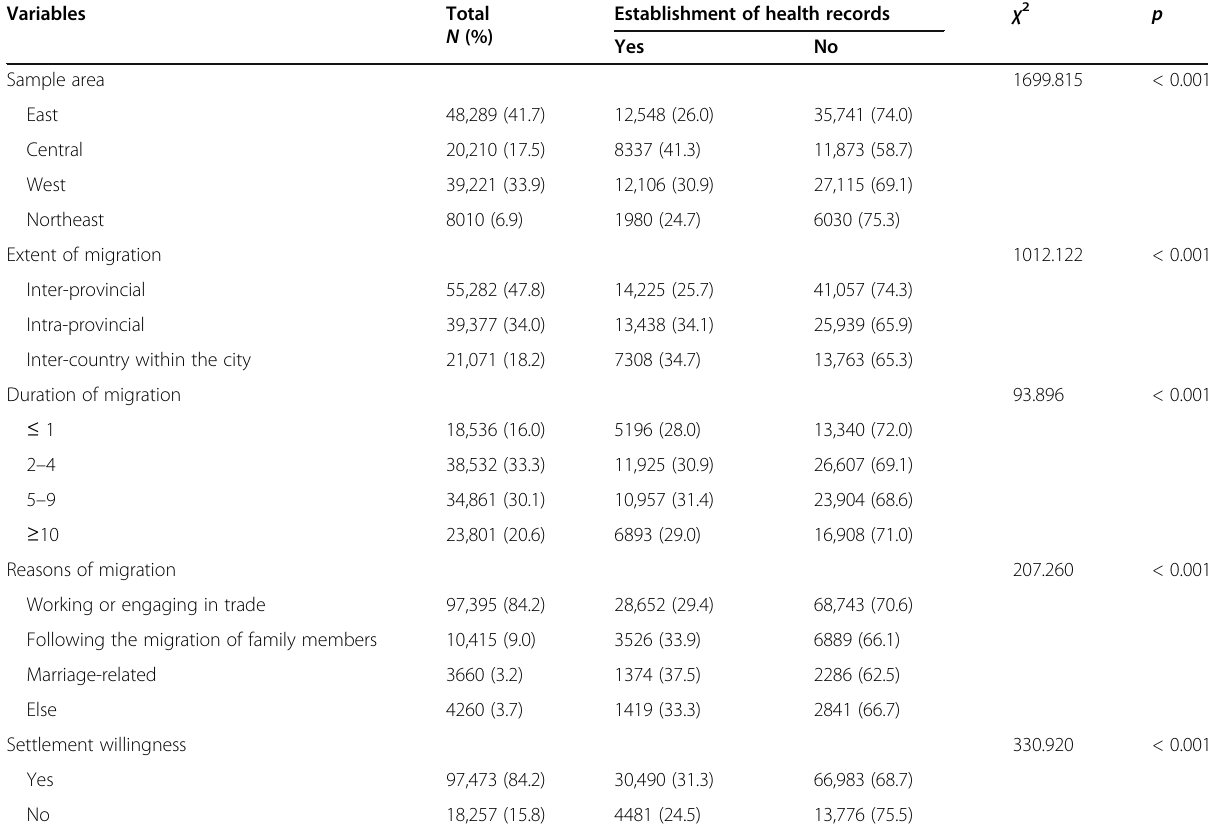
Table 2 Migration characteristics and the establishment of health records ( N = 115,730)